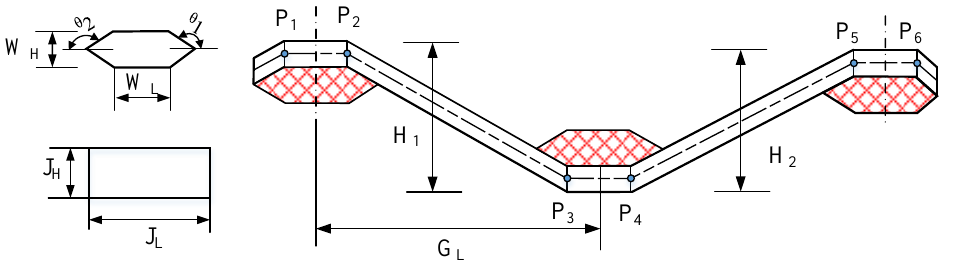
Figure 10. The uncertain geometry of 2.5D braided composite. Description of geometric parameter design of 2.5D braided uncertainty model.